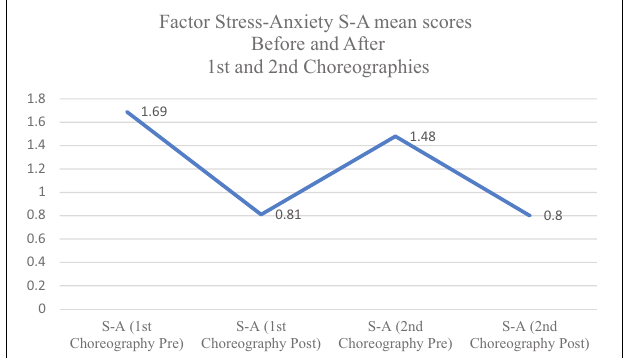
FIGURE 2 | Factor Stress-Anxiety (S-A) mean scores before (pre) and after (post) 1st and 2nd choreography.